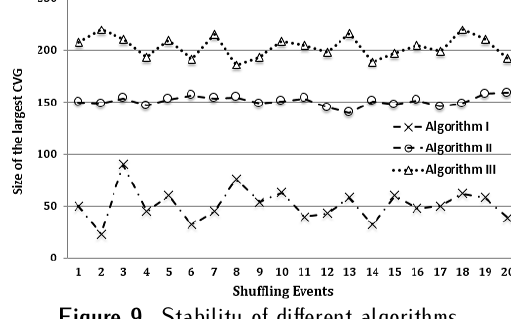
Figure 9. Stability of different